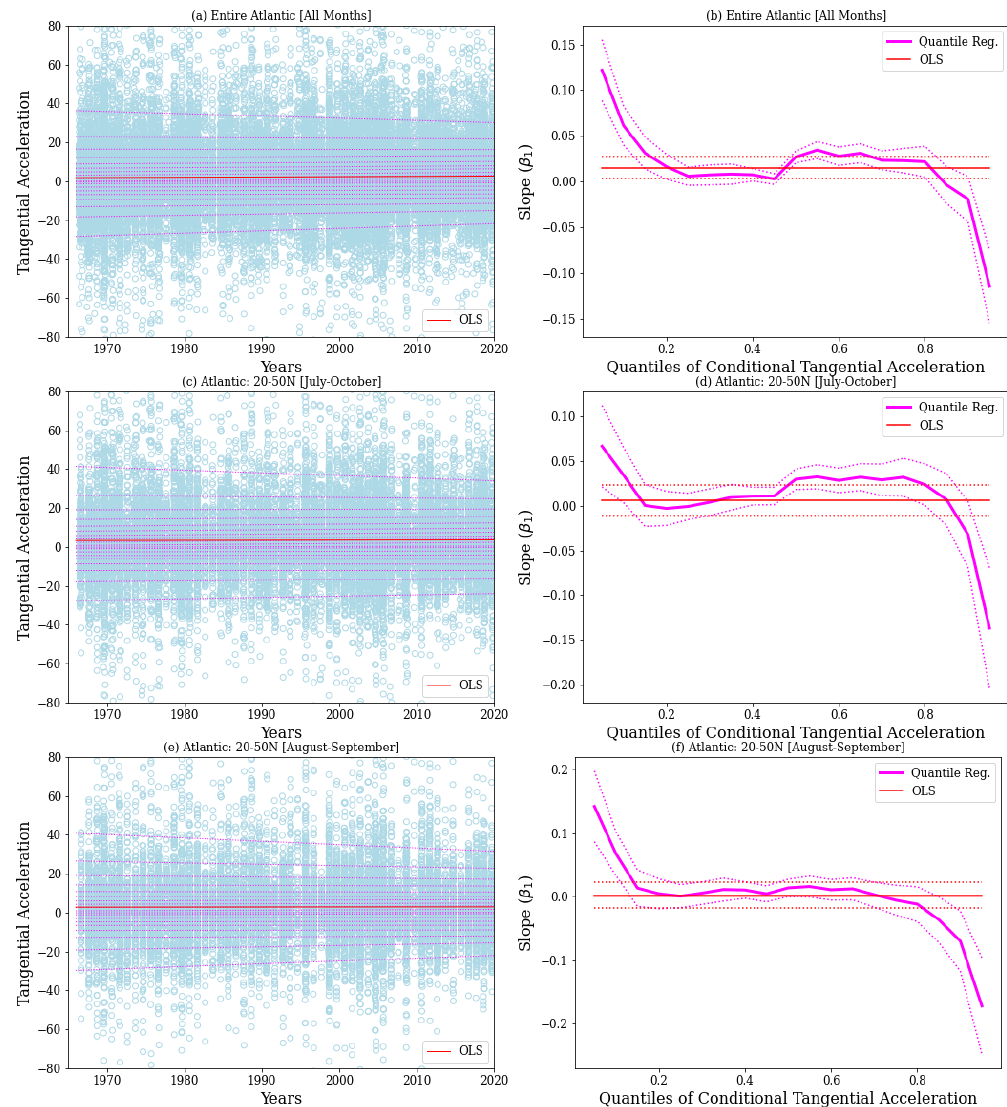
Figure 13. Quantile regressions of tangential acceleration for regions and months shown on the panels. Panels (a) , (c) , and (e) show the acceleration (light blue circles) for all TCs (NR and ET excluded) as a function of time. The dotted magenta lines show the linear fit quantiles ranging from 0.05 to 0.95. The red line shows the ordinary least square fit for the mean. Panels (b) , (d) , and (f) show the estimates of the slope (i.e., the trend in kmh − 1 d − 1 yr − 1 ) for each quantile, along with the 95% confidence band (dotted magenta). Also shown is the ordinary least square estimate of trend (red line) and its 95% confidence band for each